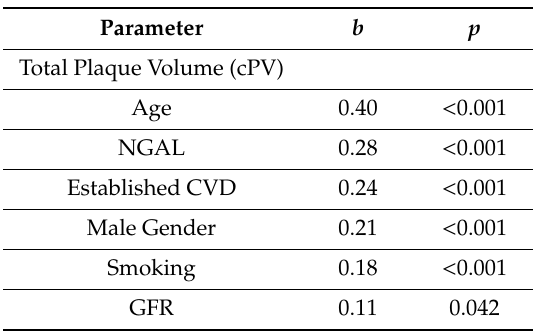
Table 3. Multivariate Regression for total